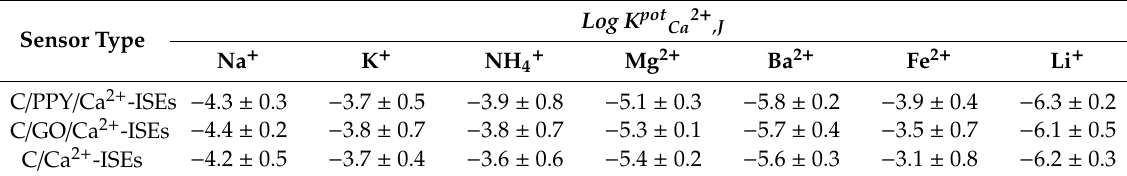
Table 2. Potentiometric selectivity coe ffi cient Log K pot Ca2 + ,J for the proposed calcium-ISEs. Sensor